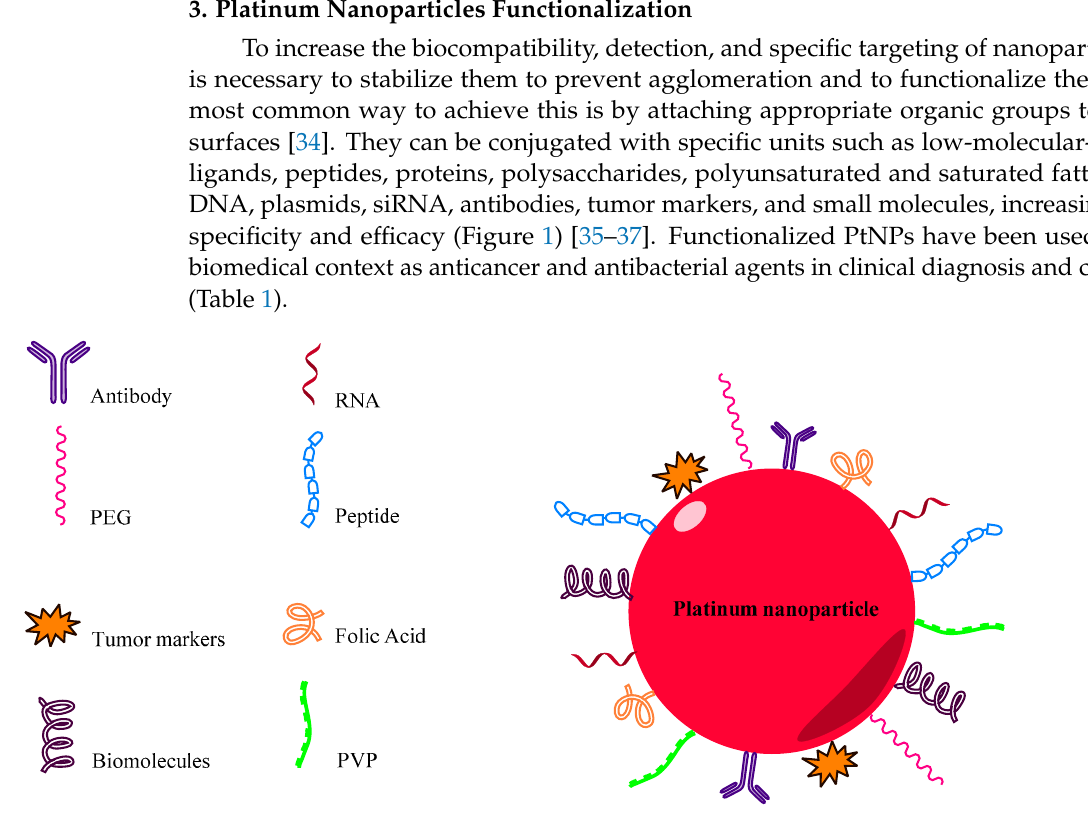
Figure 1. Functionalized PtNP through conjugation of antibodies, peptides, nucleic acids, tumor markers, biomolecules, folic acid, and polymers.